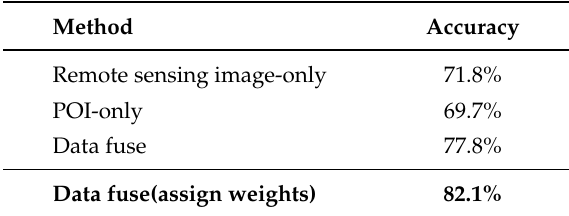
Table 6. The accuracy of single stage in remote sensing images.